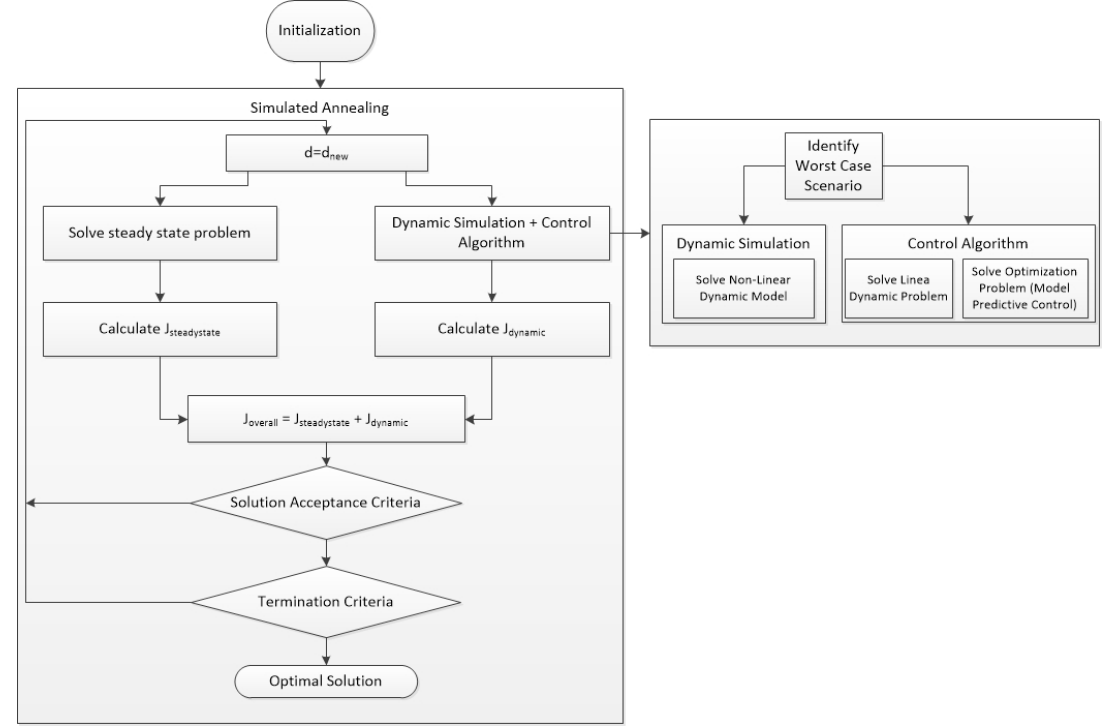
Figure 1. Solution procedure of the integrated process design problem with economic and control system performance criteria using simulated annealing.